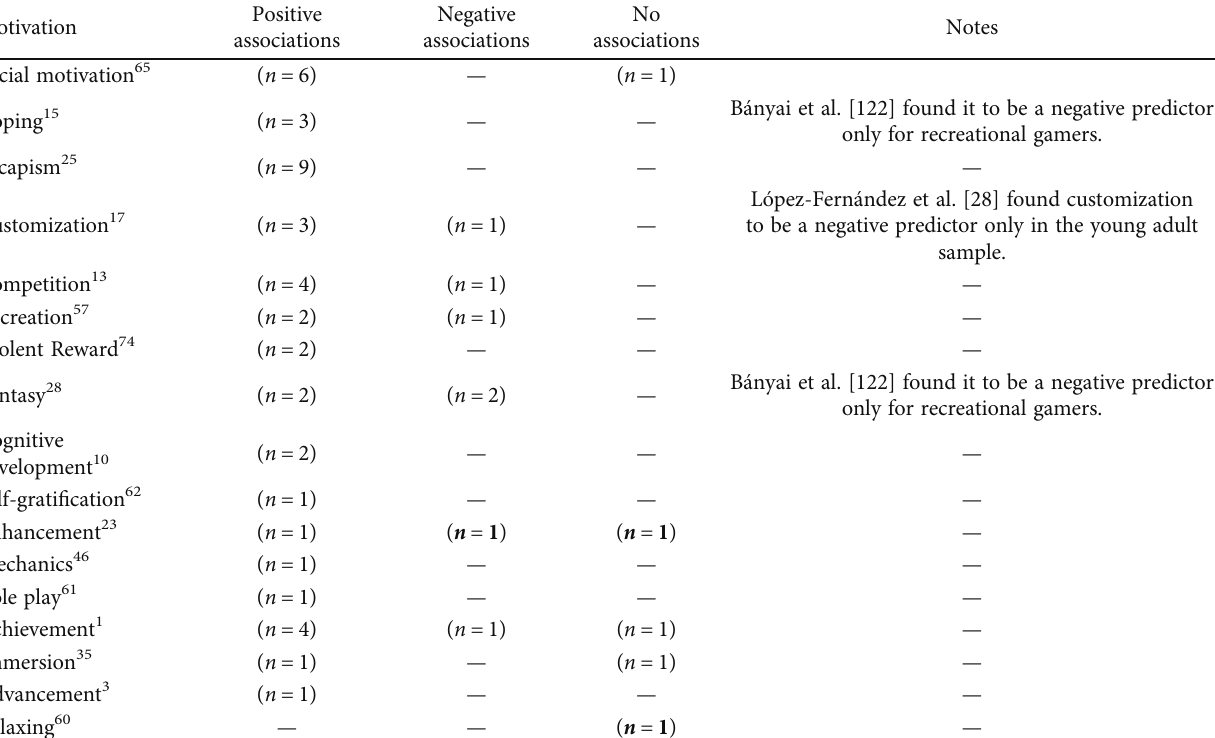
Table 7: The table summarizes the results found in literature between gaming motivations and gaming